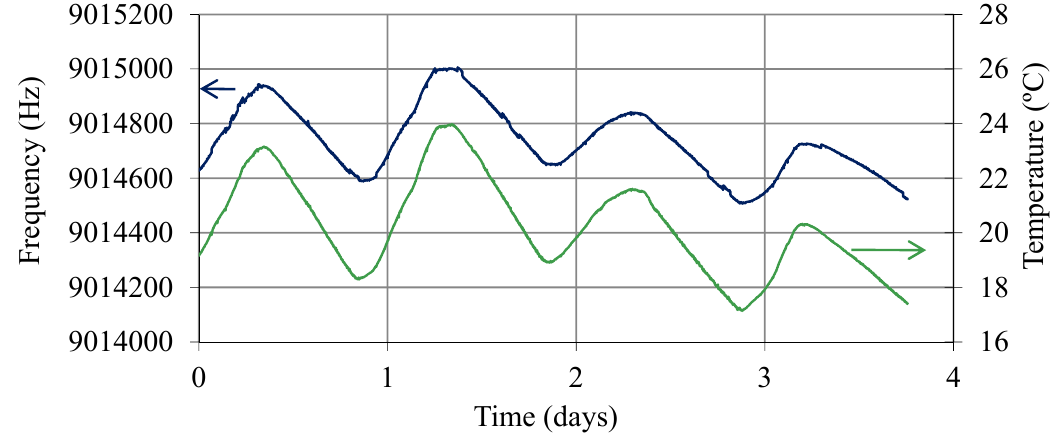
Figure 11. Oscillation frequency over four days after temperature compensation and Allan